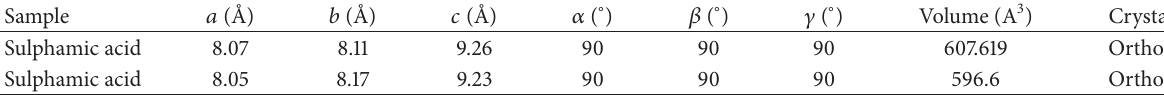
Table 1: Cell parameters of sulphamic acid single crystals.